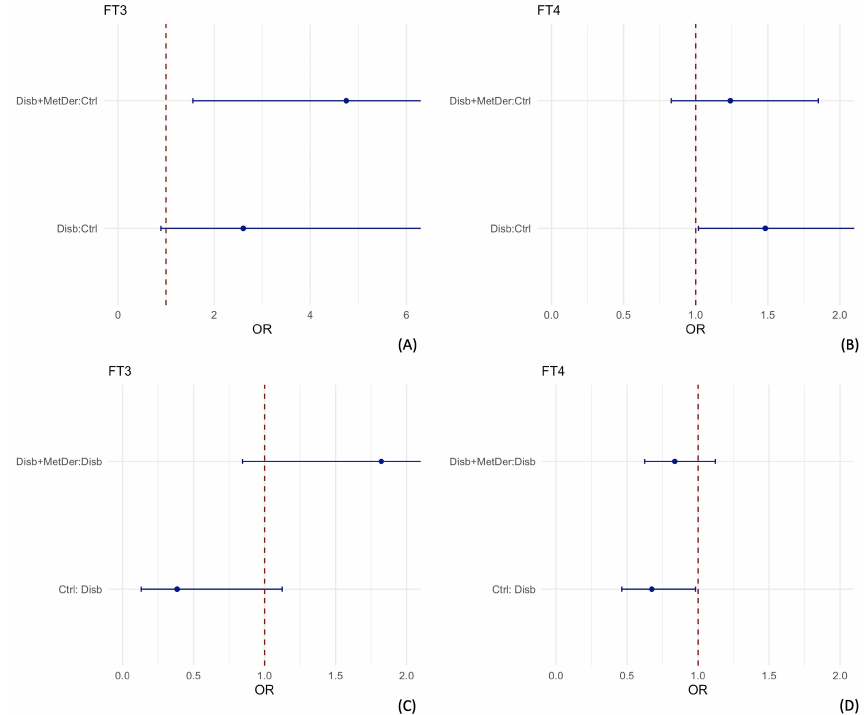
Figure 5. This figure shows the effects of FT3 and FT4 in relation to the classes of the groups studied when adjusted for the other variables included in the model. With a 1 pmol/L increase in FT3, the odds of being a child with or without MS increase, compared to control children ( A ). The same effect occurs with a 1 pmol/L increase in FT4: the odds of being a child with disability with or without MS increase, compared to control children ( B ). When children with a disability are considered as the reference ( C ), for a 1 pmol/L increase in FT3, the odds of being a child with disability and MS increase, compared to children with a disability alone, although there is no statistical evidence of the effect, as the upper confidence limit intersects the vertical line with the x-intercept set at 1. However, for a 1 pmol/L increase in FT4, the odds of being a child with a disability and MS decrease, compared to children with a disability alone, although there is no statistical evidence of the effect, as the upper confidence limit intersects the vertical line with the x-intercept set at 1 ( D ). Disab = disability; Ctrl = controls; MetDer = metabolic derangement.